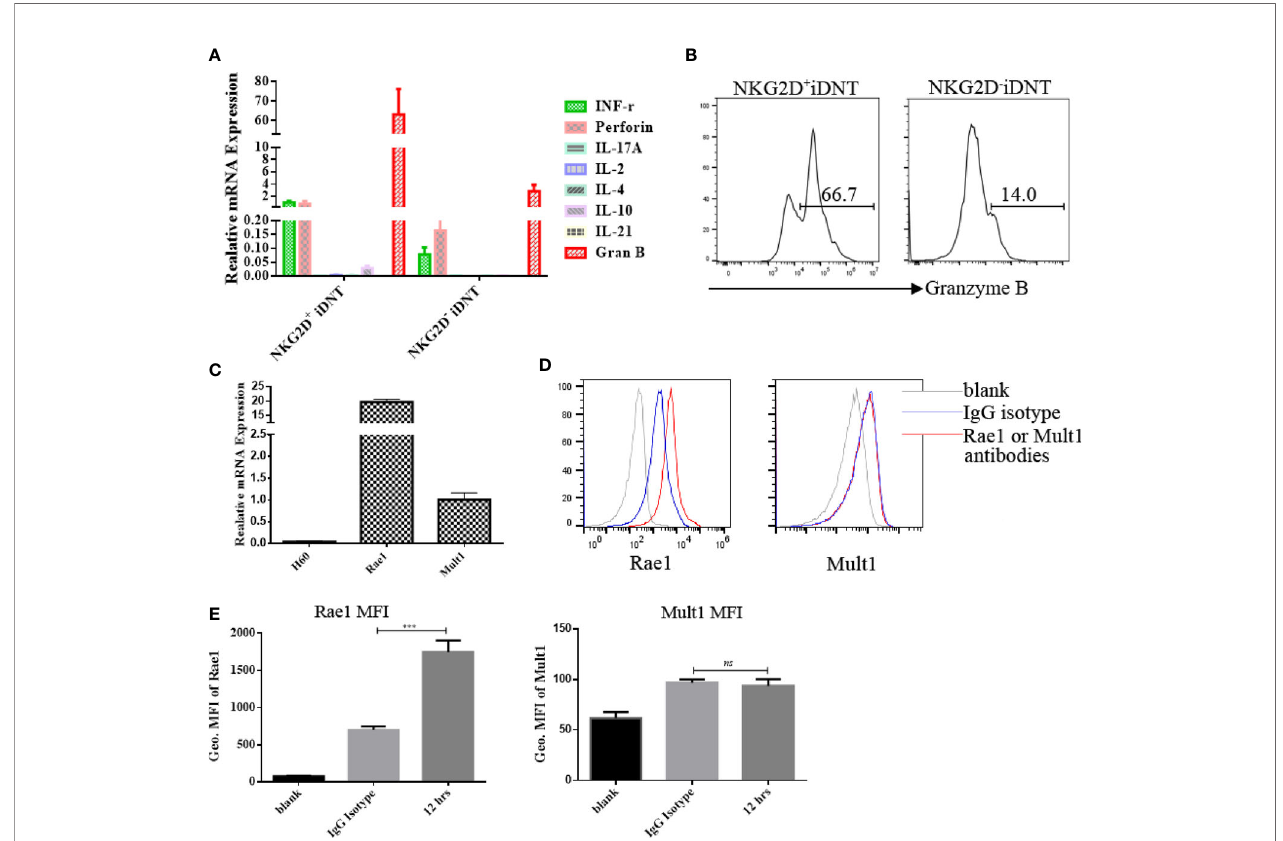
FIGURE 5 | NKG2D + iDNT cells express higher levels of granzyme B than NKG2D - iDNT cells, and activated B cells express the NKG2D ligand Rae1. (A) Q-PCR was performed to examine granzyme B mRNA levels in freshly sorted TCR ab + CD3 + CD4 - CD8 - NKG2D + and TCR ab + CD3 + CD4 - CD8 - NKG2D - iDNT cells. (B) Granzyme B protein was detected using fl ow cytometry. (C) Naïve B cells were stimulated with LPS in B cell medium for 12 hours, and q-PCR was performed to examine the expression levels of NKG2D ligands. (D) Naïve B cells were stimulated with LPS in B cell medium for 12 hours, and fl ow cytometry was performed